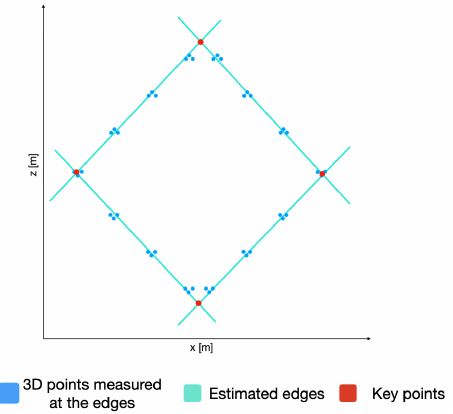
Figure 9. Acquired 3D points belonging to the calibration board and their projection on an estimated plane P .